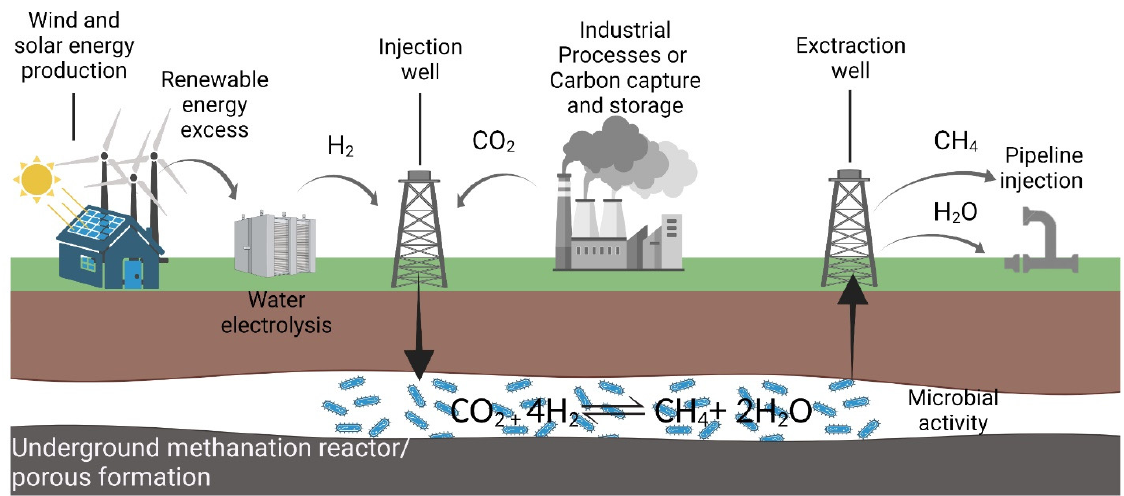
Figure 5. Schematic representation of the underground methanation reactor (UMR) concept.